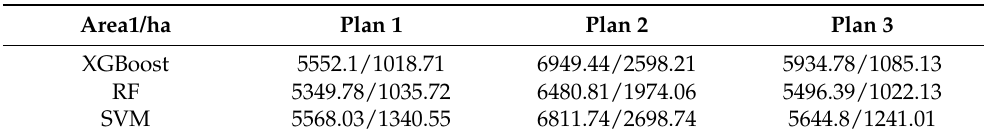
Table 6. Calculated areas occupied by PV plants in Site 1/Site 2 based on different models and plans (unit: